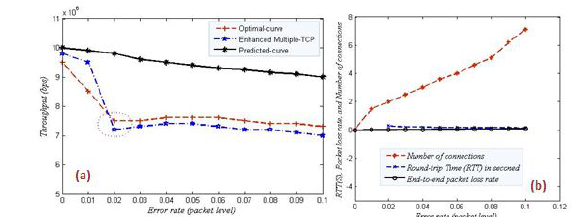
Fig. 8. (a)Throughput versus packet level; (b) RTT, no. of connections, and error rate versus packet level